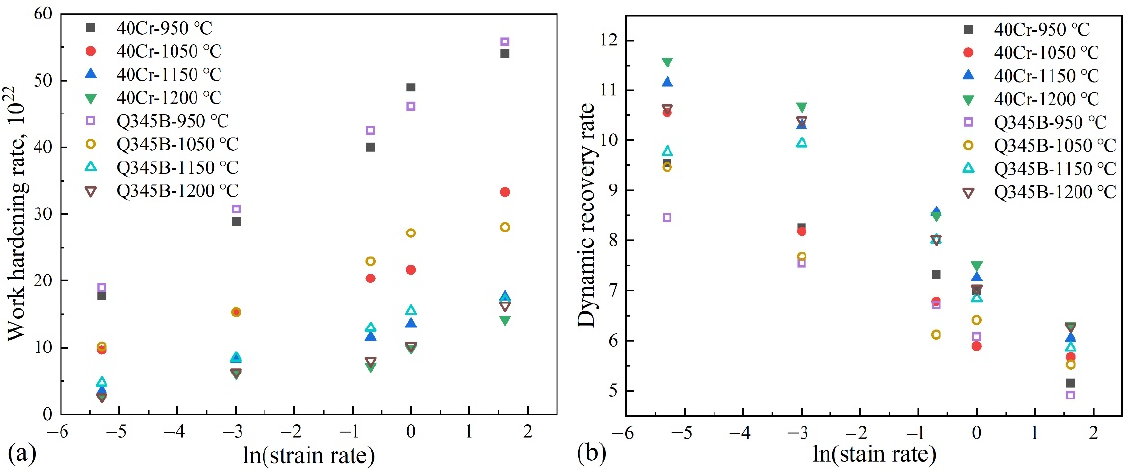
Figure 6. Calculated D ( a ) and γ ( b ) of 40Cr and Q345B. In addition, under the same deformation conditions, the D of 40Cr is lower than that of Q345B, while the γ is higher than that of Q345B, and the difference gradually decreases with the increasing temperature. This may be due to the solute drag effect and the second phase particles pinning effect. At the studied temperature, the solute drag effect is caused by the difference in the diffusion rate between the solute atoms and the base atoms, which impedes the dislocation motion and accelerates the dislocation multiplication [10]. The atomic radius difference between Mn and Fe is very close to that between Cr and Fe, so the solute drag effect produced by the two elements is close. Carbon, as an interstitial atom, more easily causes lattice distortion. Some reports [24,44] show that the addition of carbon can reduce WH at high temperatures and low strain rates, and increase recovery rate. Meanwhile, MnS, as the second phase particle, has a strong pinning effect on the dislocation motion, which increases the dislocation density by forming more dislocation entanglements and rings [11]. The WH effect is enhanced due to the increase of dislocation density. Moreover, DRV involving rearrangement and annihilation of dislocations is restrained by